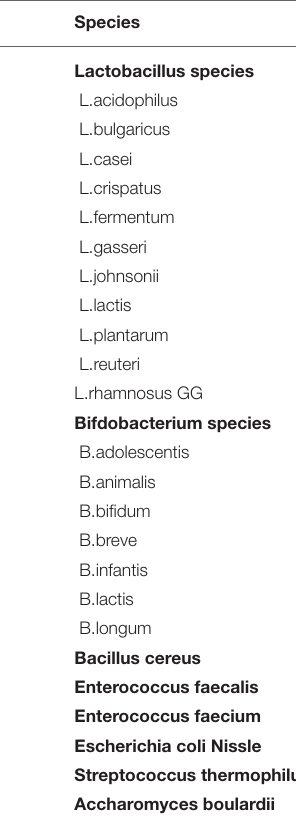
TABLE 1 | Microorganisms used as